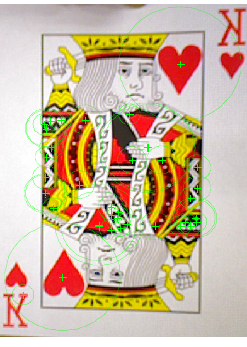
Figure 16. Features of the king of hearts pattern.